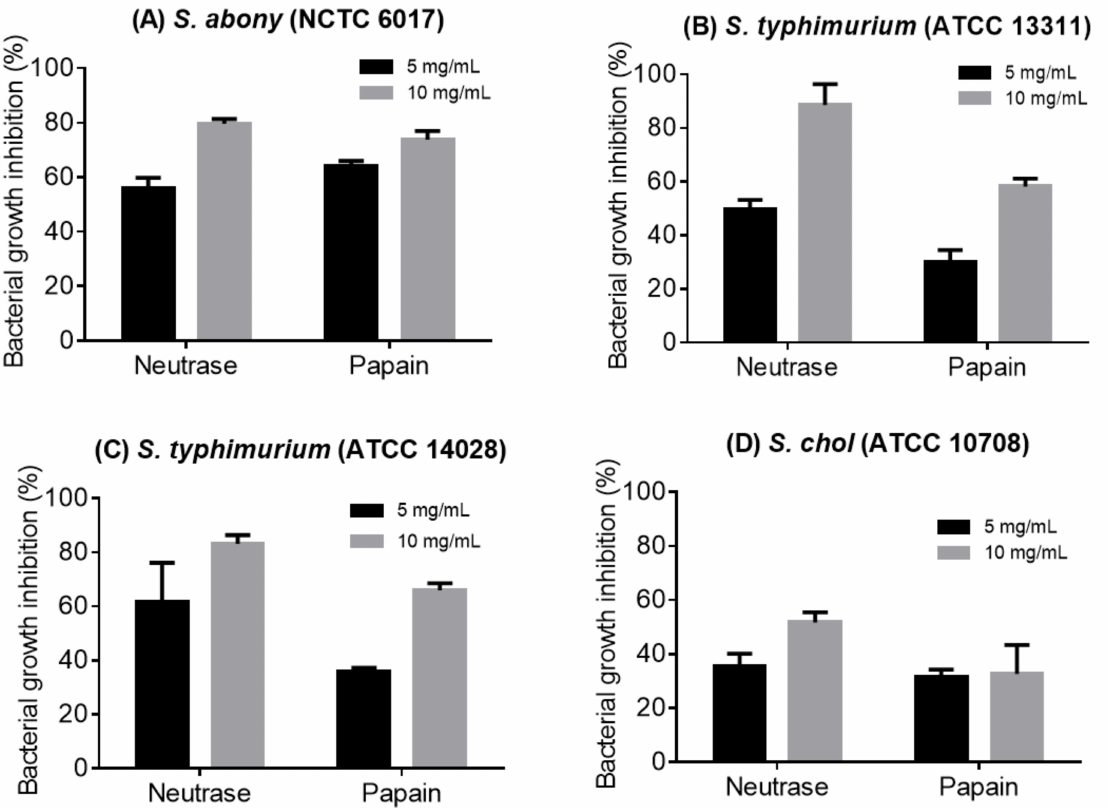
Figure 4. Growth inhibition of Salmonella strains in the presence of collagen acetone fractions ( A ): S. abony (NCTC 6017); ( B ): S. typhimurium (ATCC 13311); ( C ): S. typhimurium (ATCC 14028) and ( D ): S. chol (ATCC 10708).